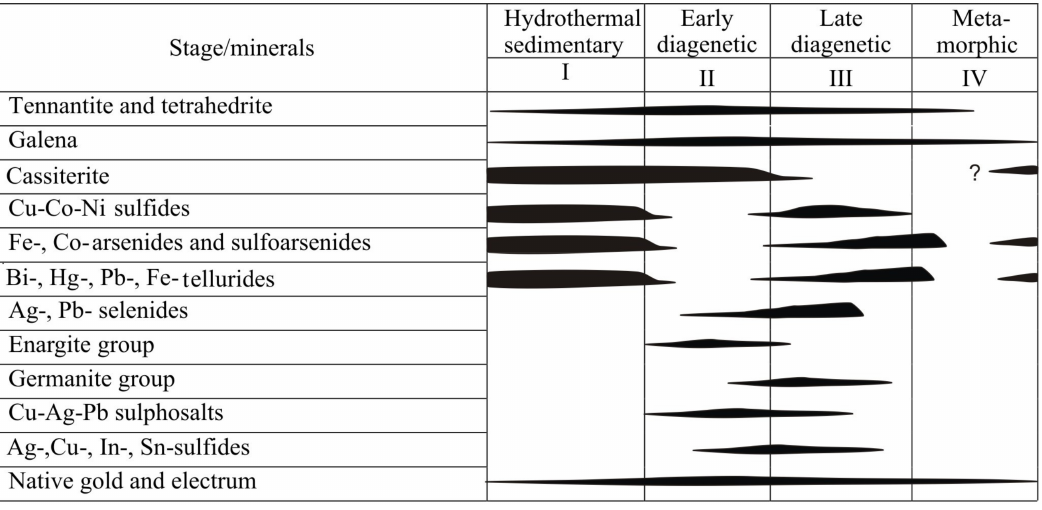
Figure 21. Succession of formation of subordinate and minor minerals of ore diagenites of the Urals VHMS